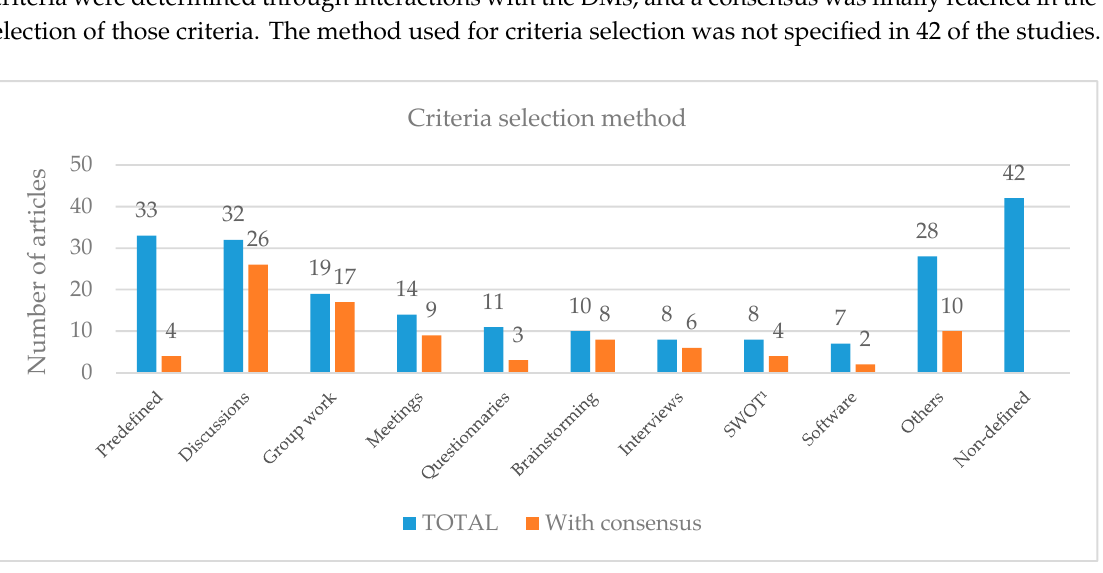
Figure 2. Criteria selection method. 1 SWOT analysis: Strengths, Weaknesses, Opportunities, Threats.